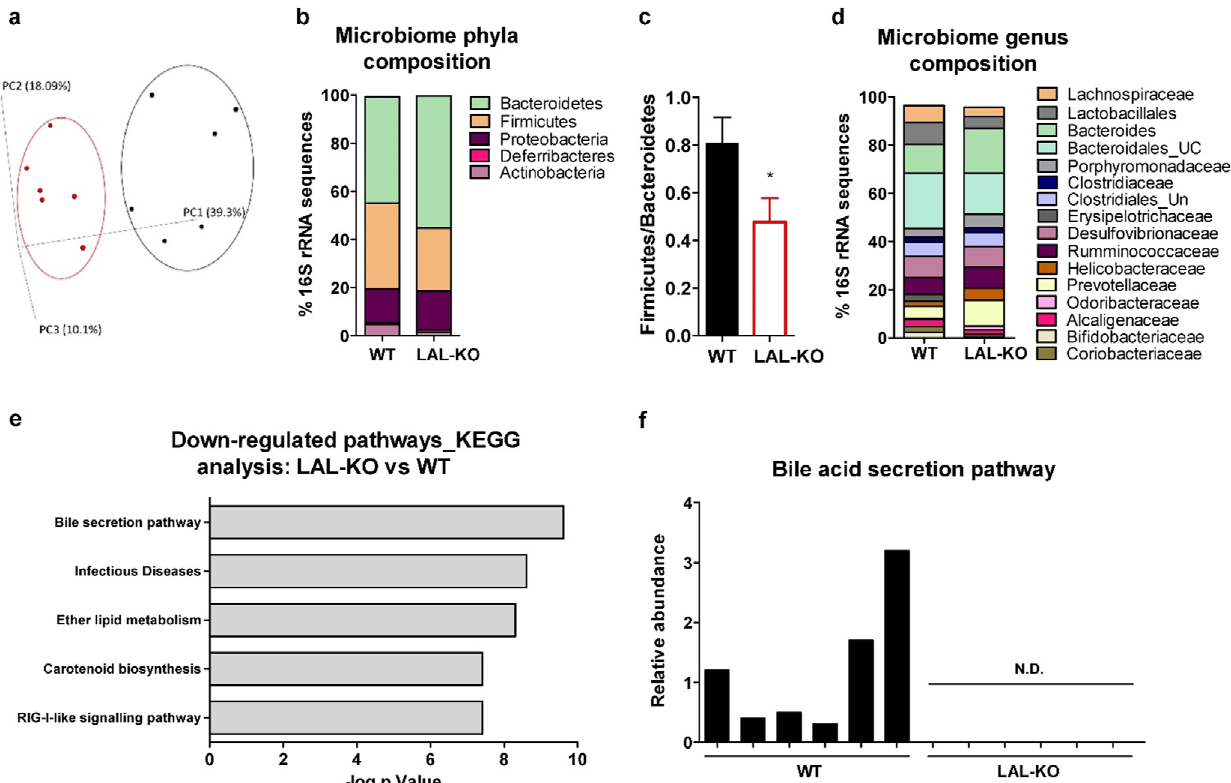
Figure 6. Pronounced shift in cecal microbial communities in LAL-KO mice: Cecal contents of WTD-fed male mice were extracted, and gut bacterial communities were analyzed by 16S rRNA sequencing (n = 6). ( a ) Principal component analysis (PCoA) of groups (WT, black; LAL-KO, red) denote the separation of the colonic microbial community. ( b ) Phylum-level changes, showing average percentages of each phylum as a proportion of the whole community based on genotype; only phyla with relative abundance >0.5% in at least one sample are displayed. ( c ) Ratio of Firmicutes to Bacteroidetes phyla. ( d ) Genus-level changes, showing the average percentage of each genus as a proportion of the whole community based on genotype. For simplicity, only genera with relative abundance >0.1% are displayed. UC, unclassified; UN, unknown. ( e ) Top 5 downregulated biochemical pathways in LAL-KO vs. WT mice based on KEGG analysis. ( f ) Metagenomic modeling using Phylogenetic Investigation of Communities by Reconstruction of Unobserved States (PICRUST) reveals pathways enabling bile secretion. Data represent mean values + SD; p < 0.05 (*), ( c ) Student’s unpaired